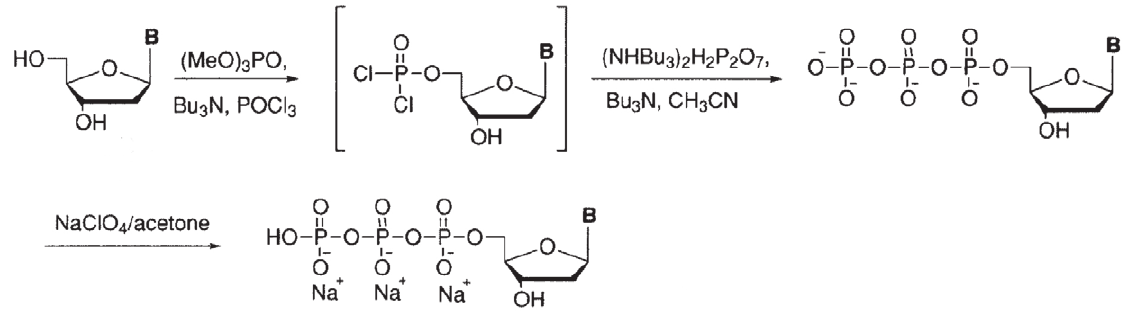
Figure 1 Preparation of purine-specific dNTPs, where B represents adenine or guanine.The procedures for preparing the pyrimidine dNTPs are very similar to the above, except that Bu N added in the first reaction for the purine nucleosides is not required for dCTP and replaced 3 by proton sponge for TTP and dUTP, with the corresponding 2 ′ -deoxynucleosides as starting materials. Reproduced from Kore et al. (3) , copyright 2012, with permission of Current Protocols & John Wiley & Sons,